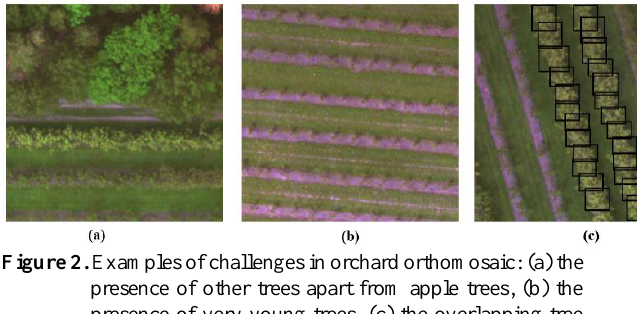
Figure 2. Examples of challenges in orchard orthomosaic: (a) the presence of other trees apart from apple trees, (b) the presence of very young trees, (c) the overlapping tree crowns indicated in the two middle